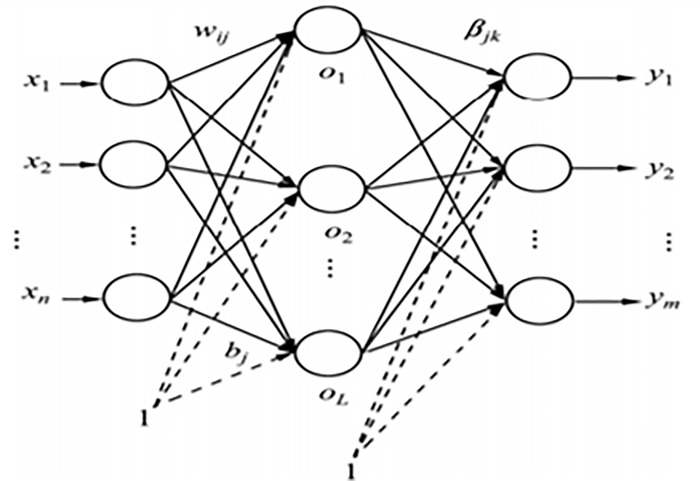
BP neural network model.